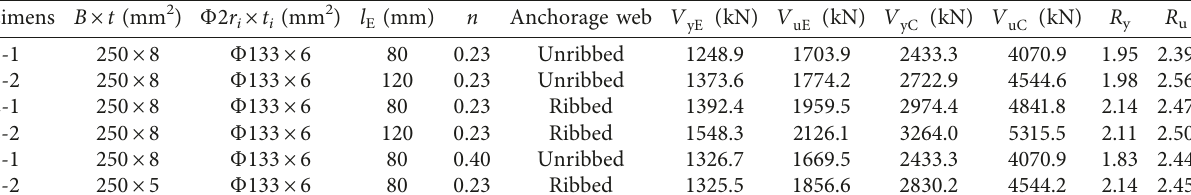
Table 1: Summary of the joint specimens and analysis results.